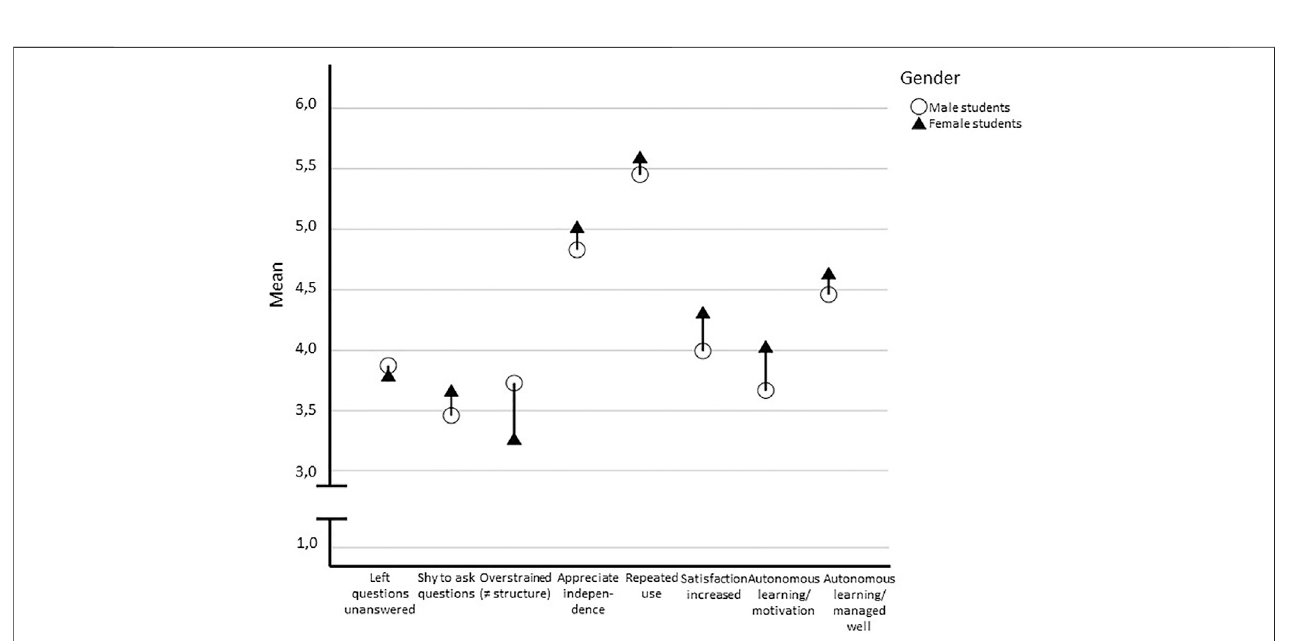
FIGURE 2 | Drop-line chart showing the difference of positive and negative perceptions of digital teaching between male and female